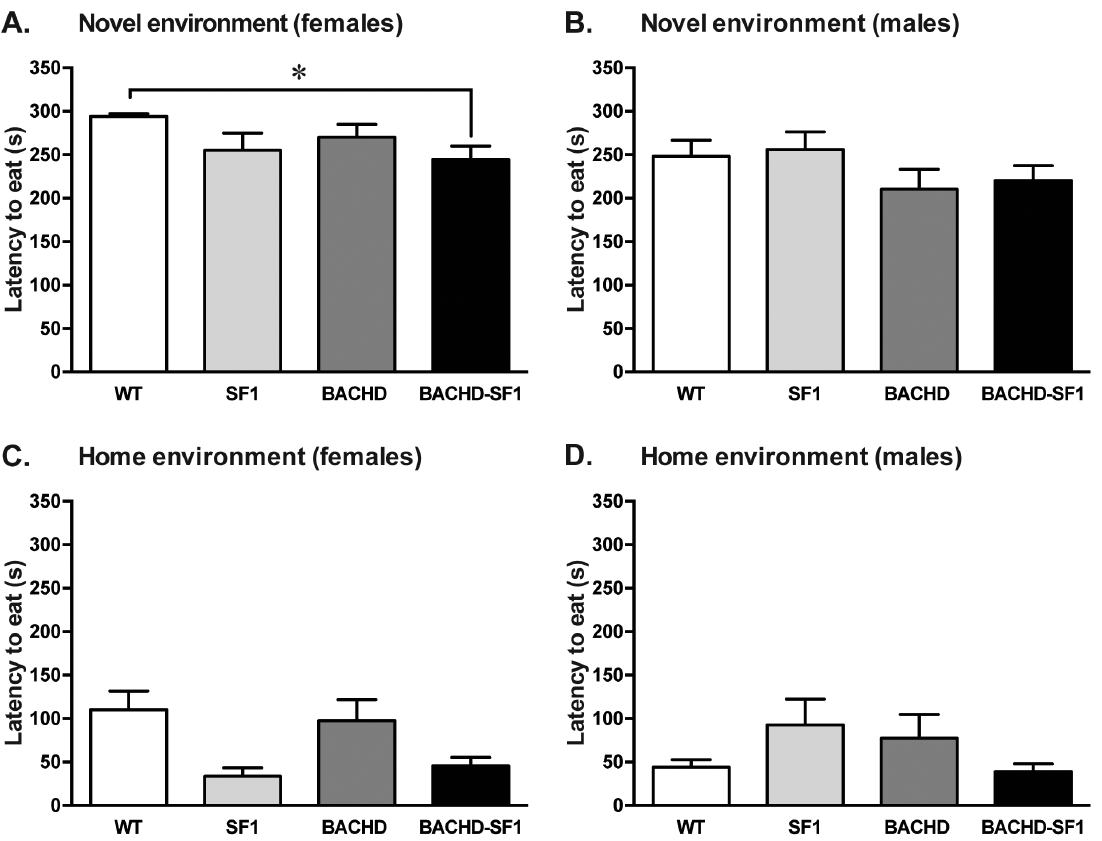
Figure 5. Latency to feed during the novelty-induced suppressed feeding test (NSFT). During the NSFT, the latency to feed in a novel environment as well as in the home cage was assessed. A, B. In females, BACHD-SF1 mice recorded a decreased latency to eat in the novel environment compared to WT controls but there were no differences in the male group across the genotypes. C, D. There were no differences in the latency to feed in the home environment in both sexes across the genotypes. Data presented as mean 6 SEM (* p , 0.05, Kruskal-Wallis non- parametric ANOVA with Dunn’s multiple comparisons test), n=11–28/genotype/sex in each group. Detailed statistical analyses are outlined in Figure 5 of Statistical Results S1.